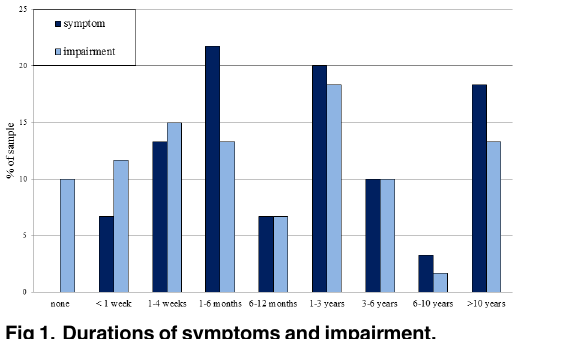
Fig 1. Durations of symptoms and impairment.